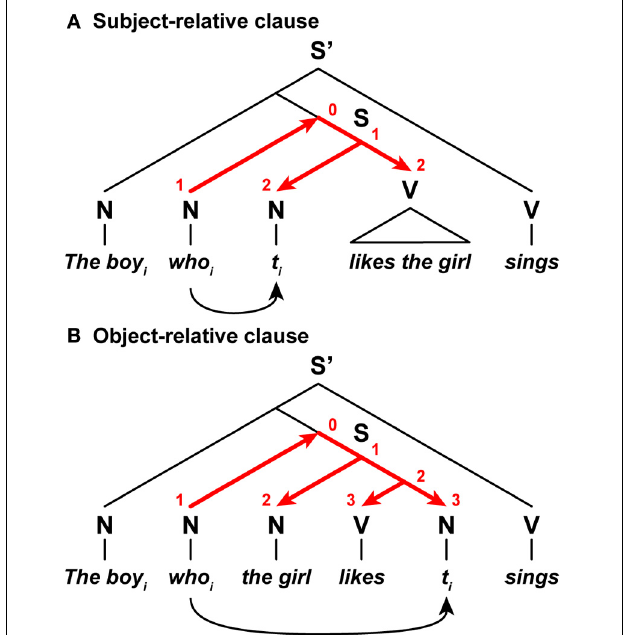
FIGURE 8 | The DoM domains varied with the Search distances. (A) A sentence with a subject-relative clause. (B) A sentence with an object-relative clause. In these relative clauses, a relative pronoun who i is displaced from its subject or object position denoted by a trace t i . A set of red straight arrows corresponds to the DoM domain. The digits shown in red denote the DoM for each node within the domain. Symbols used: S and S’, sentence; N, noun phrase; V, verb phrase; t i , trace (subscripts denote the same